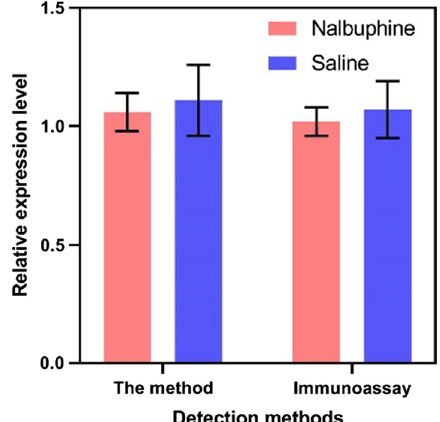
Fig. 5 Relative thrombin expression level in nalbuphine-treated group and saline-treated